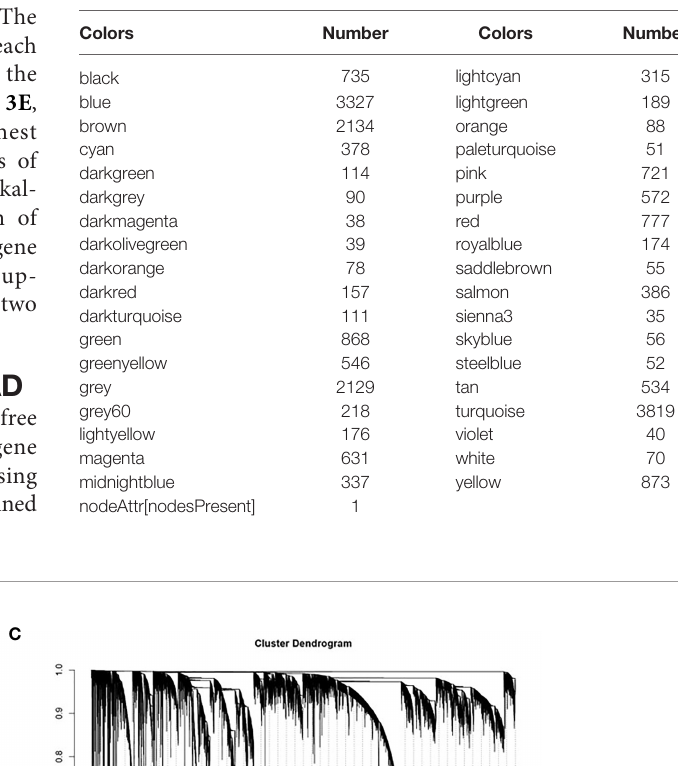
TABLE 3 | Gene module colors and corresponding